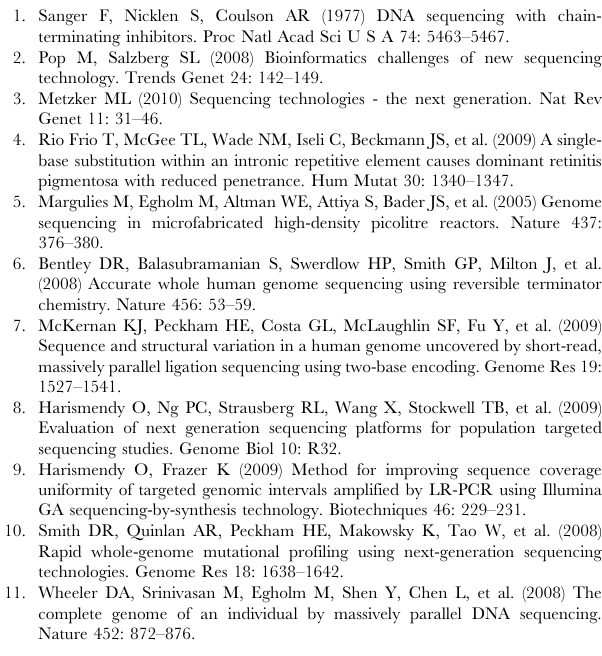
Table S4 Deletions detected with Roche 454 (false positives), using trimmed reads. The deletion at position 30,672 was also found using the other 2 platforms, likely being the only real small